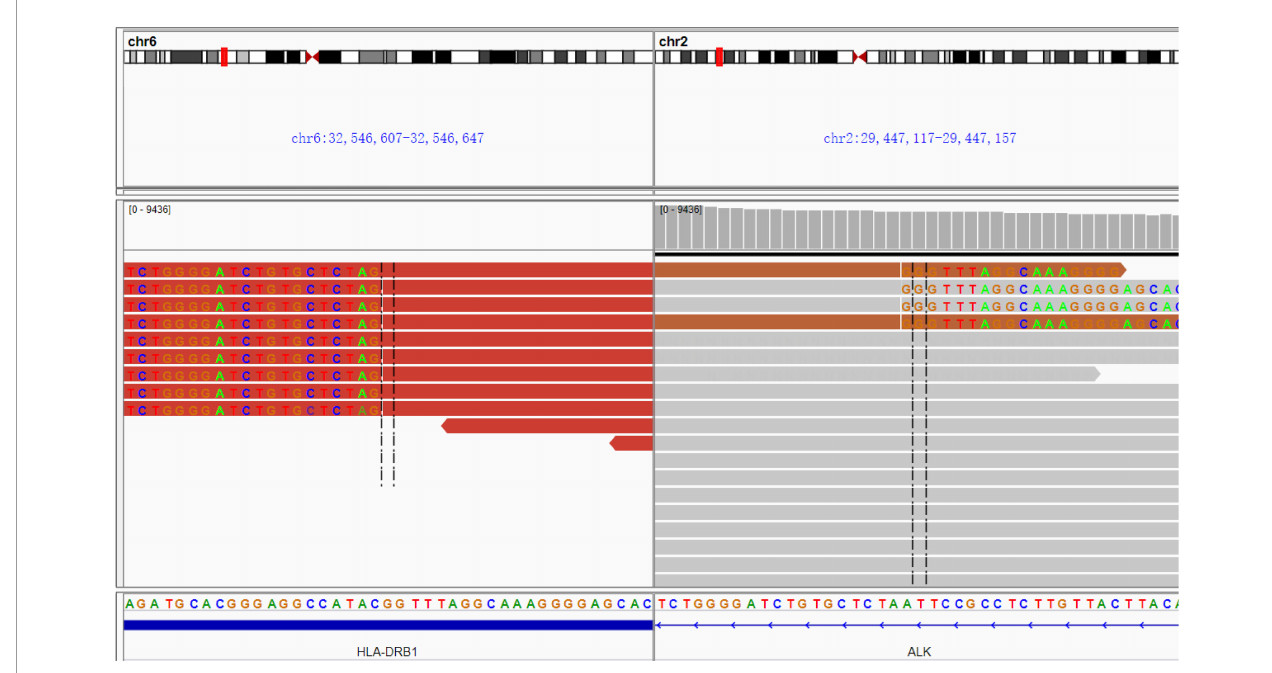
FIGURE 3 | Screenshot of the Integrative Genomics Viewer from the next-generation sequencing fusion assay showing abundant supporting RNA reads with an ALK-HLA-DRB1 fusion, which consisted of exon 20 of the ALK gene and exon 8 of the HLA-DRB1 gene. The plasma ALK fusion abundance was 1.9%. Detection organization: Nanjing Shihe Jiyin Biotech Inc Laboratory; Detection platform: Illumina Hiseq/MiSeqDx; Reference genome: